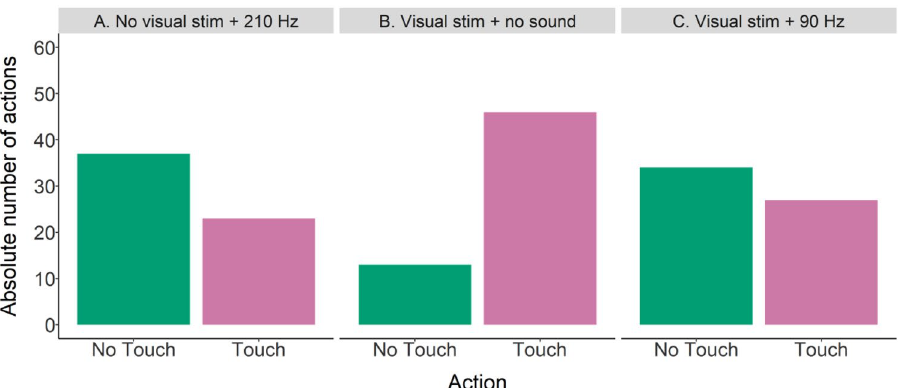
Figure 7. Grouped data (N = 3) for absolute number of action (not touching or touching the loudspeaker) and transfer type (A, B or